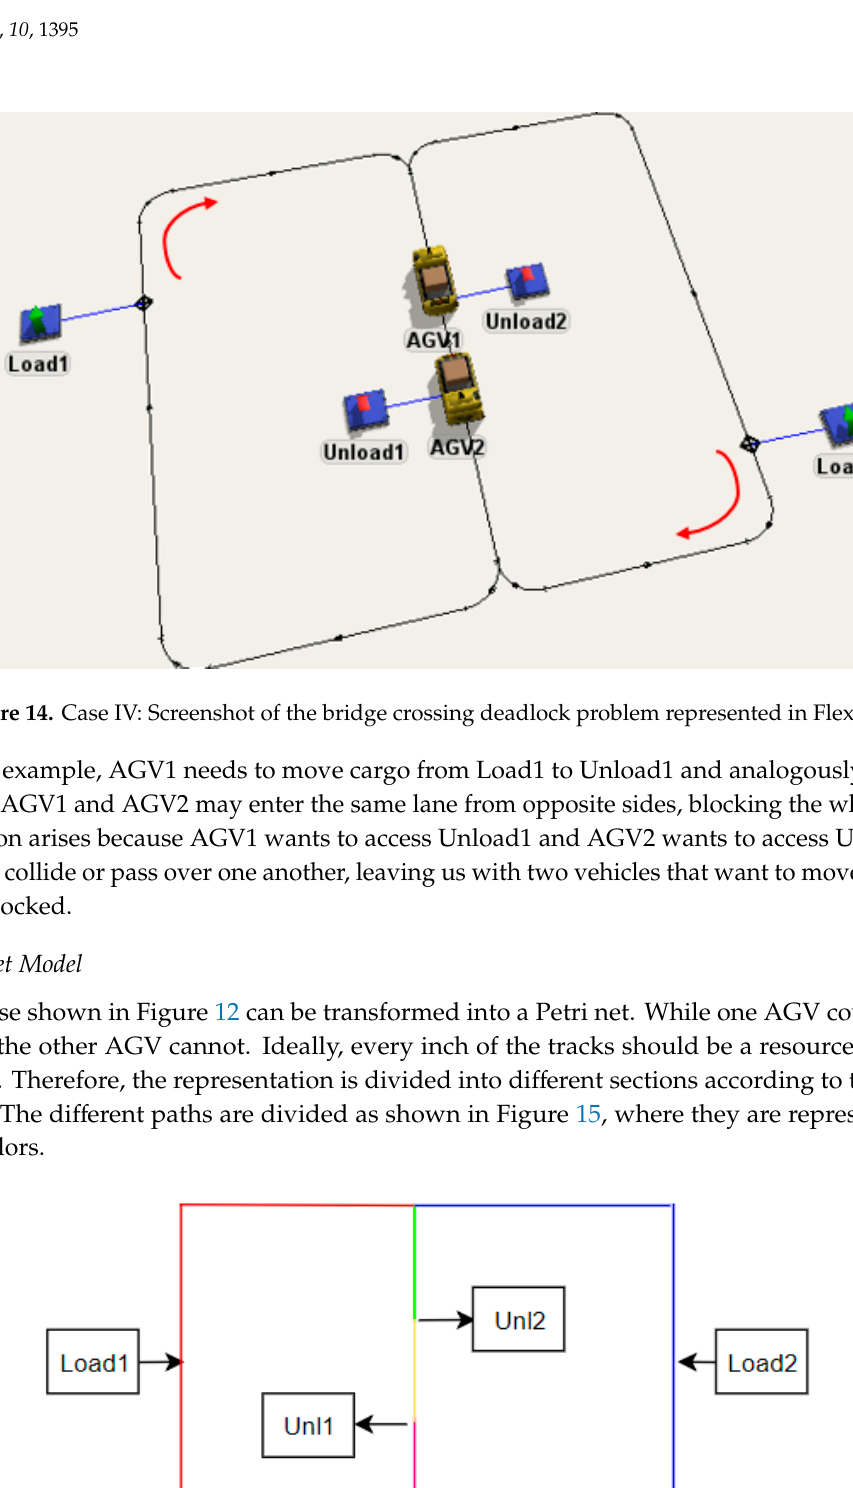
Figure 16. Case IV: initial marking of Petri net. In this case, we had to assume that there is just one part waiting to be loaded at both load stations; when it returns it waits to be loaded again so it can be represented in the PIPE simulator. Figure 17 shows the different terminal states in which two different systems can be found (S10 and S11).